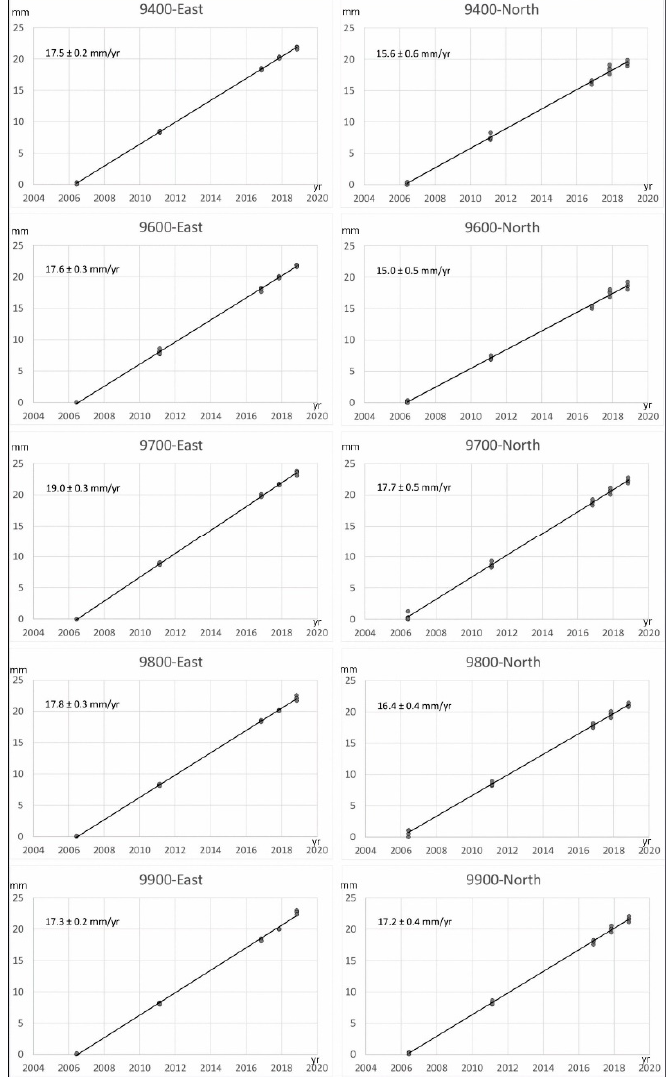
Figure 3. Position time series of the Campo de Dalias network stations (north and east components in millimeters). Absolute velocities are included in Table 1.